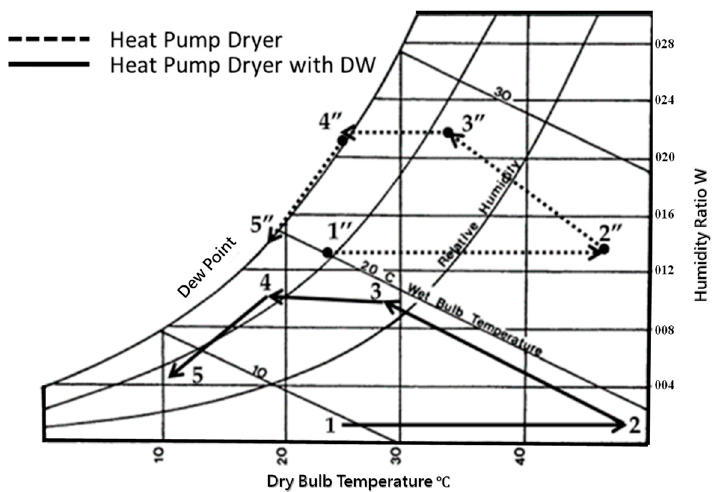
Figure 5. Psychrometric representation of drying air paths of both systems.